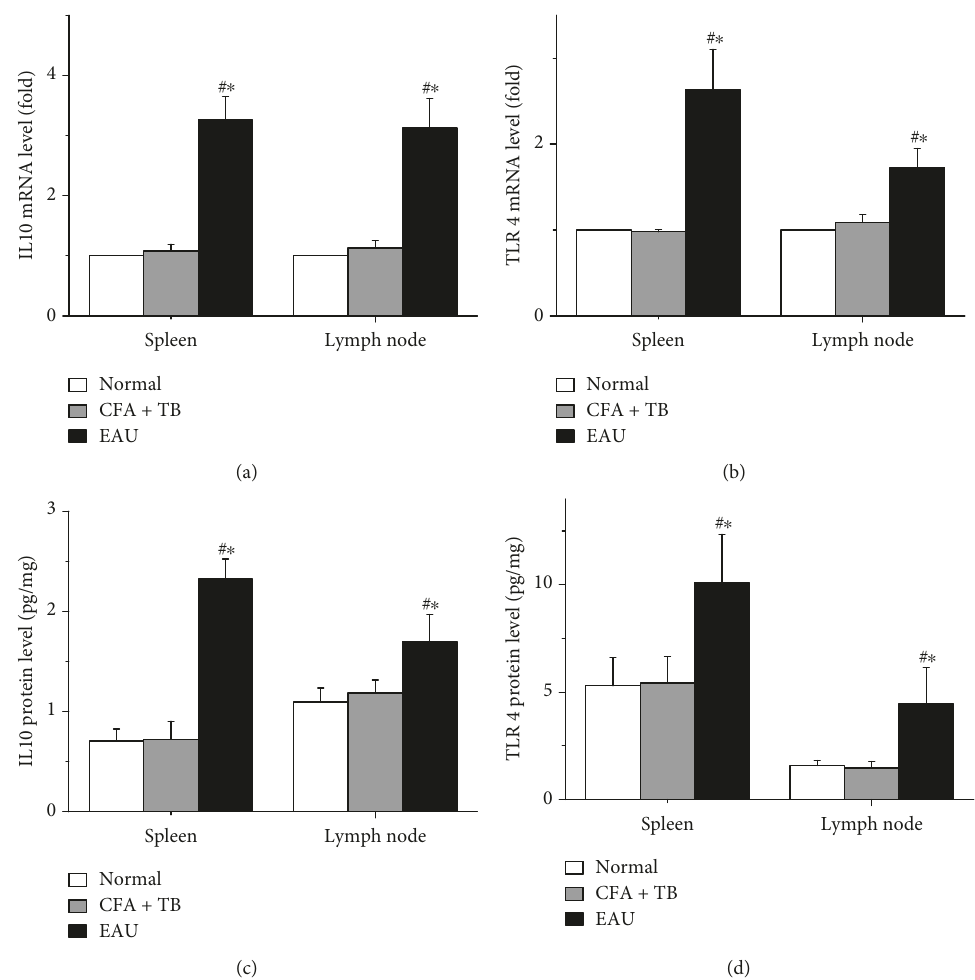
Figure 3: Expressions of IL-10 and TLR4 mRNA and proteins in spleen and lymph nodes in rats. (a) expressions of IL-10 mRNA; (b) expressions of TLR4 mRNA; (c) expressions of IL-10 protein; (d) expressions of TLR4 protein. # P < 0 05 compared with the normal control group. ∗ P < 0 05 compared with the CFA+ TB